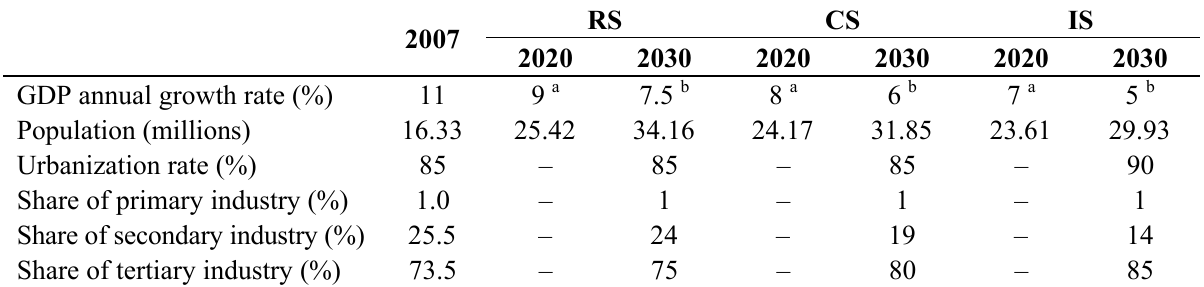
Table 2. Key assumption parameters of the LEAP-Beijing model under the three scenarios.